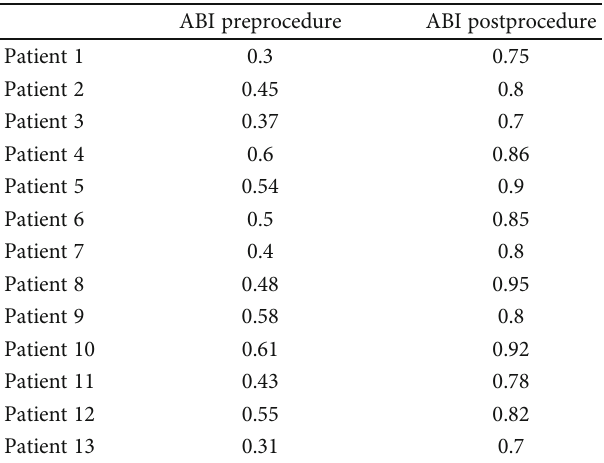
Table 2: Ankle-brachial index, pre- and postprocedure.